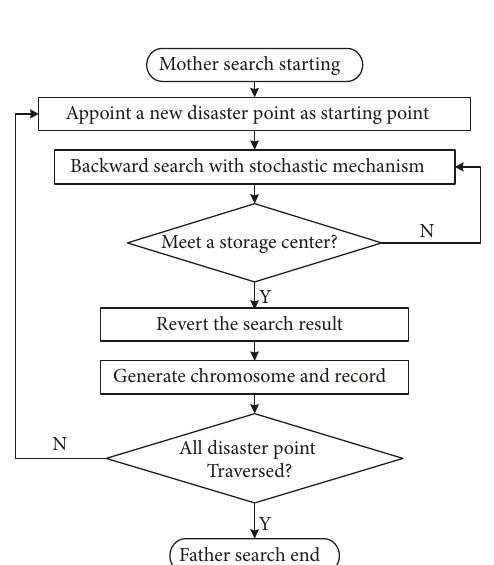
Figure 4: Flow chart of father search.